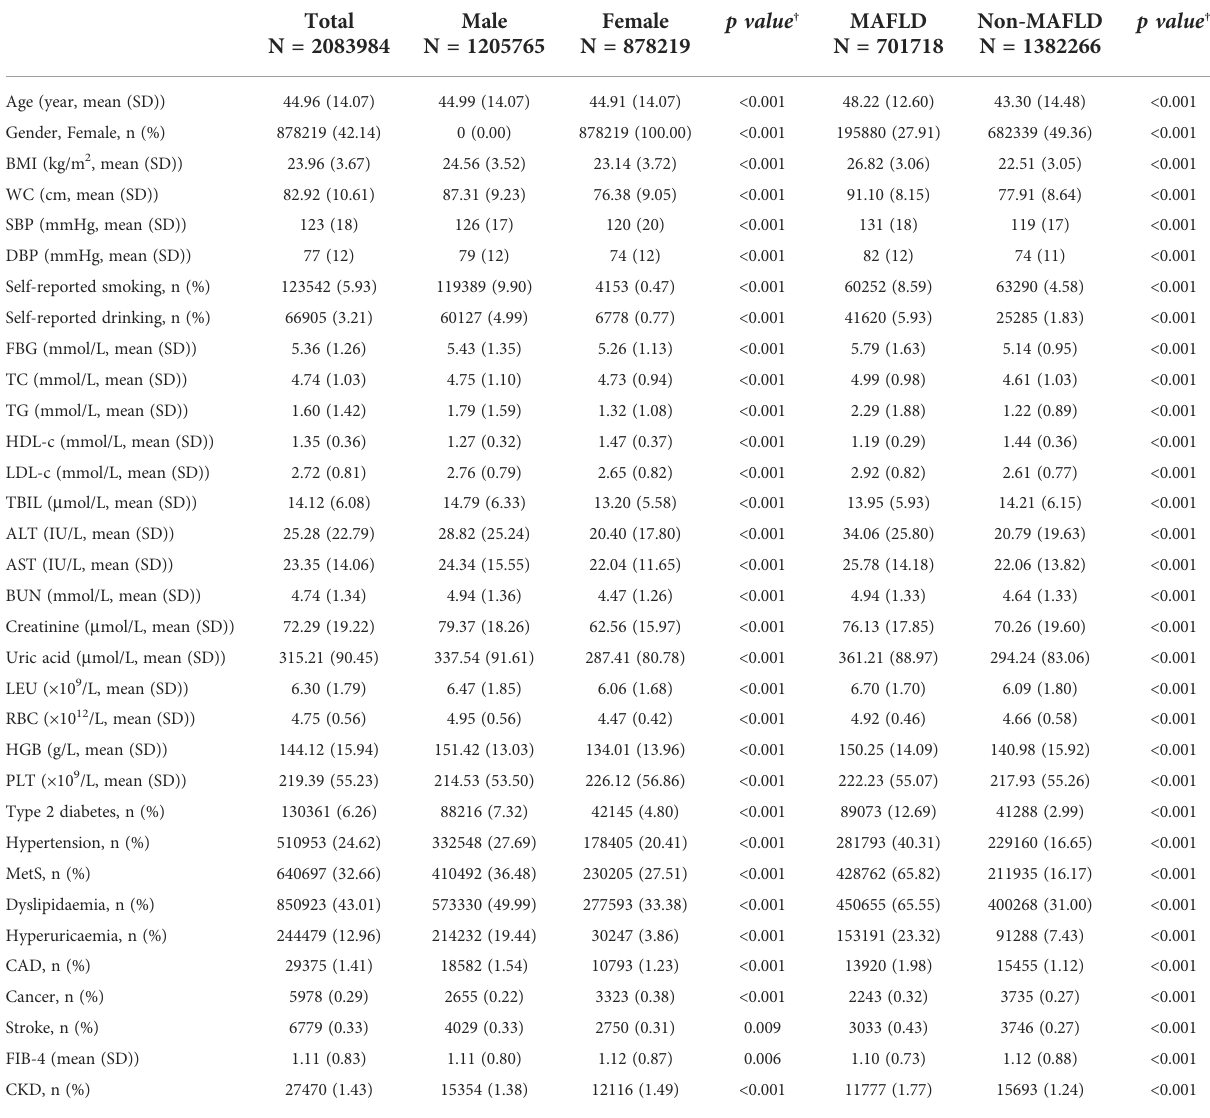
TABLE 1 Baseline Characteristics for the Cross-sectional Population. Total Male Female p value †